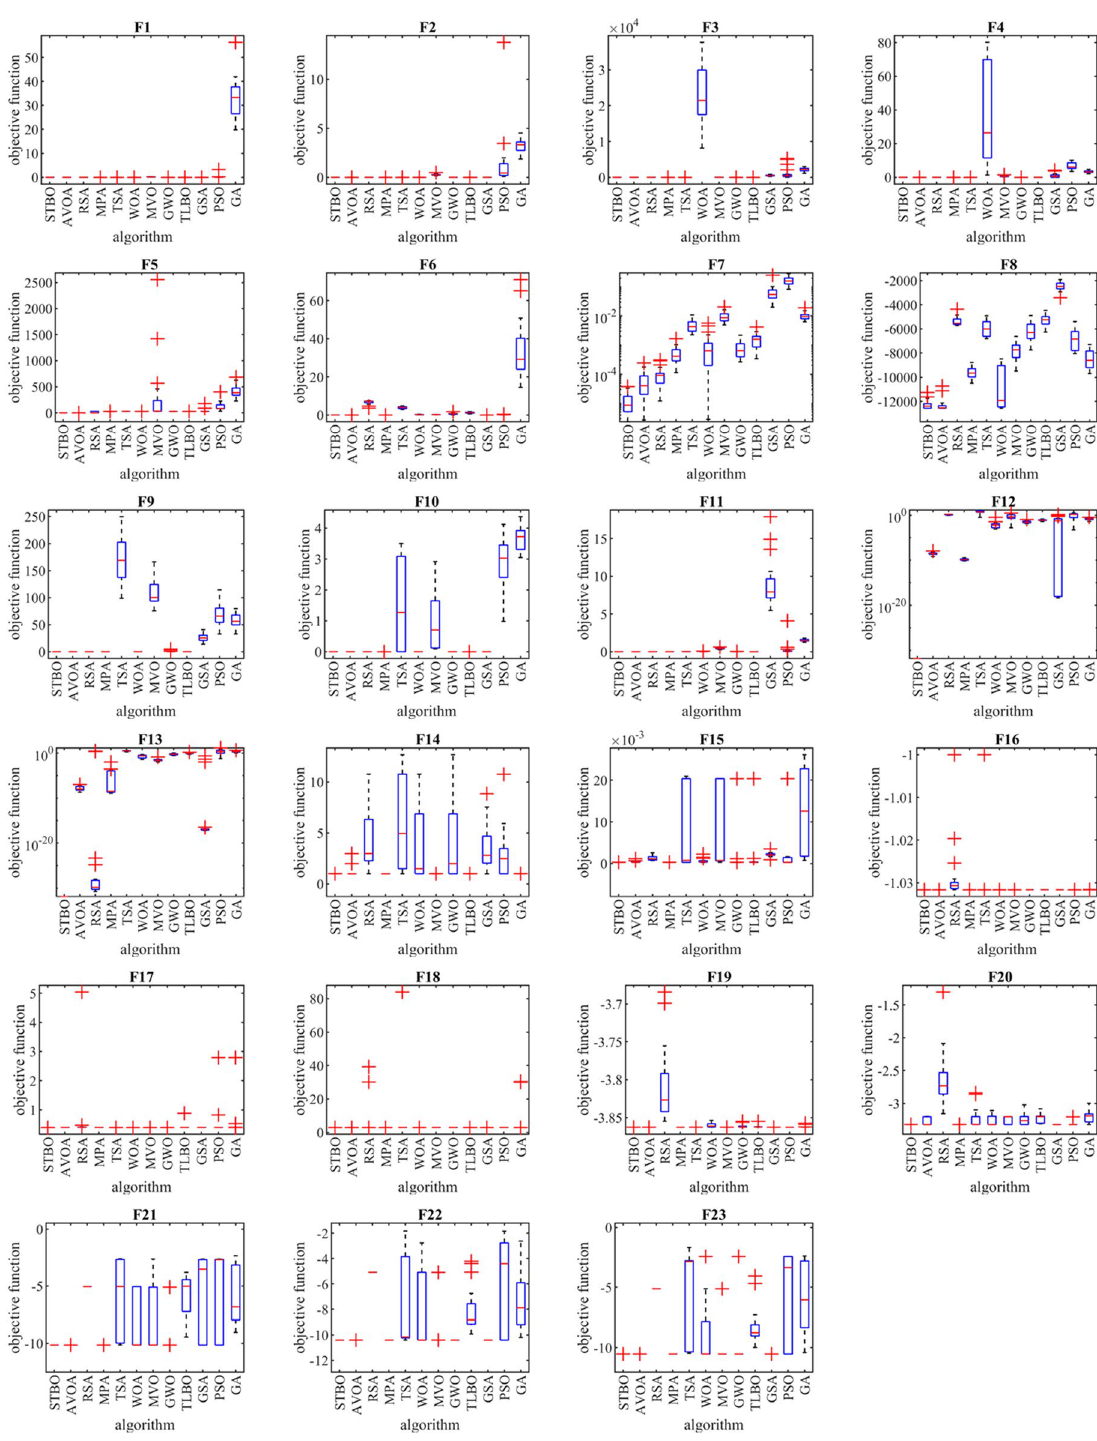
Figure 1. Boxplot of performance of STBO and competitor algorithms in solving F1 to